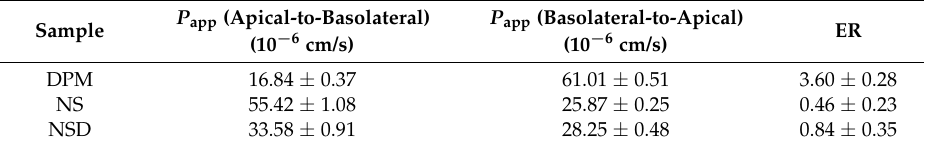
Table 2. Bi-directional P app and ER data of the coarse DPM, NS, and NSD samples in Caco-2 cell monolayer. Values are represented as mean ± standard deviation.